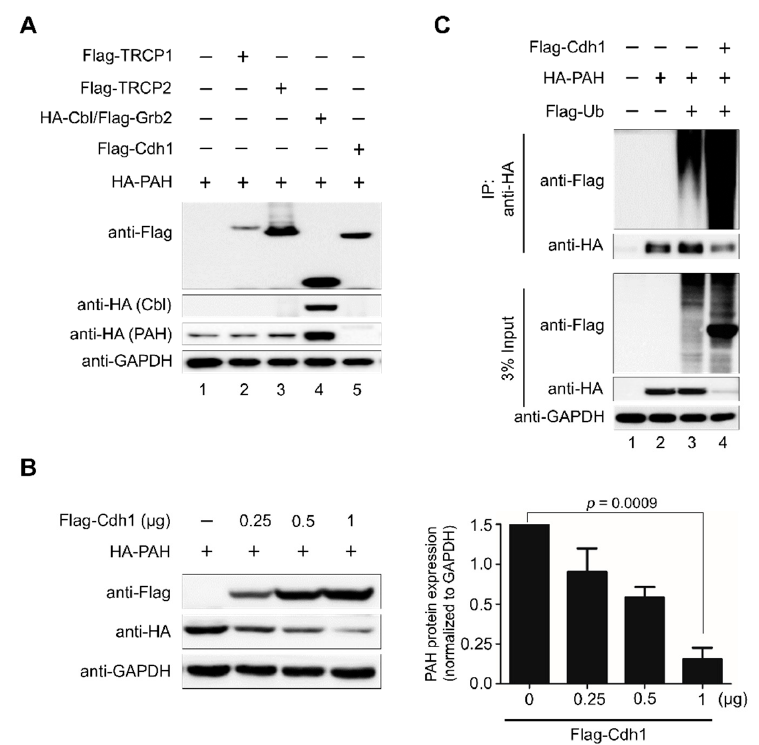
Figure 2. APC / C Cdh1 is the E3 ligase responsible for PAH protein degradation. ( A ) HEK293 cells were transfected with di ff erent E3 ligases along with ectopically expressing HA-PAH. Downregulation of PAH was analyzed by Western blotting. GAPDH was kept as a loading control. ( B ) HEK293 cells were transfected with a constant amount of HA-PAH (1 µg) along with increasing concentrations of Flag-Cdh1 (0, 0.25, 0.5, 1 µg). Band intensity was estimated using ImageJ software, normalized with GAPDH, and represented graphically. Data were presented as the mean and standard deviation of three independent experiments. One-way ANOVA followed by Tukey's post hoc test was used, and p -values are indicated. ( C ) E ff ect of overexpression of Cdh1 on the ubiquitination and proteasomal degradation of HA-PAH was determined. HEK293 cells were transfected with HA-PAH, Flag-ubiquitin, and Flag-Cdh1 and immunoprecipitated with HA antibody and immunoblotted with indicated